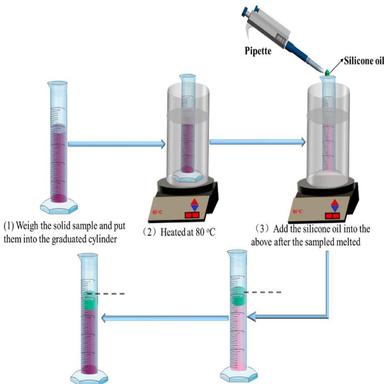
The schematic diagram of measuring the density and volume thermal expansion coefficient.